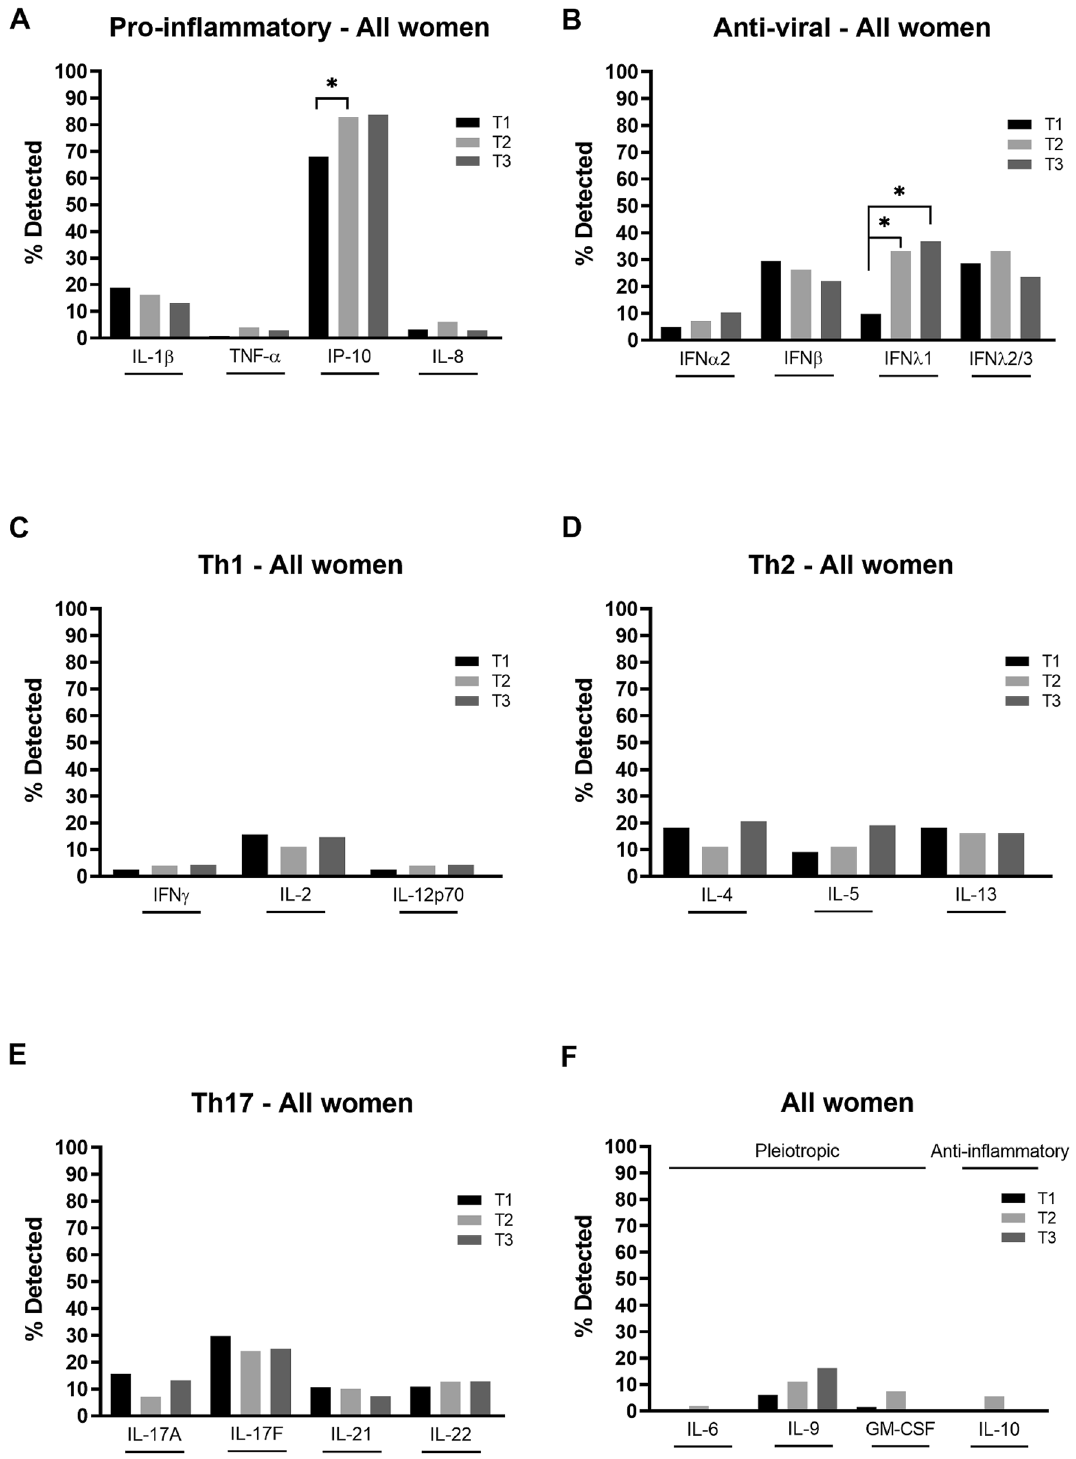
Figure 1. Systemic pro-inflammatory, anti-viral, Th1, Th2, Th17, pleiotropic and anti-inflammatory cytokines across pregnancy. ( A ) Pro-inflammatory (IL-1β, TNF-α, IP-10, IL-8), ( B ) anti-viral (IFNα2, IFNβ, IFNλ1, IFNλ2/3), ( C ) Th1 (IFNγ, IL-2, IL-12p70), ( D ) Th2 (IL-4, IL-5, IL-13), ( E ) Th17 (IL-17A, IL-17F, IL-21, IL-22) and ( F ) pleiotropic and anti-inflammatory (IL-6, IL-9, GM-CSF and IL-10 respectively) cytokines were measured in maternal plasma collected during the first (T1), second (T2) and third (T3) trimester. Data are presented as the percentage of samples in which cytokines were detected by multiplex cytokine assay. *P <